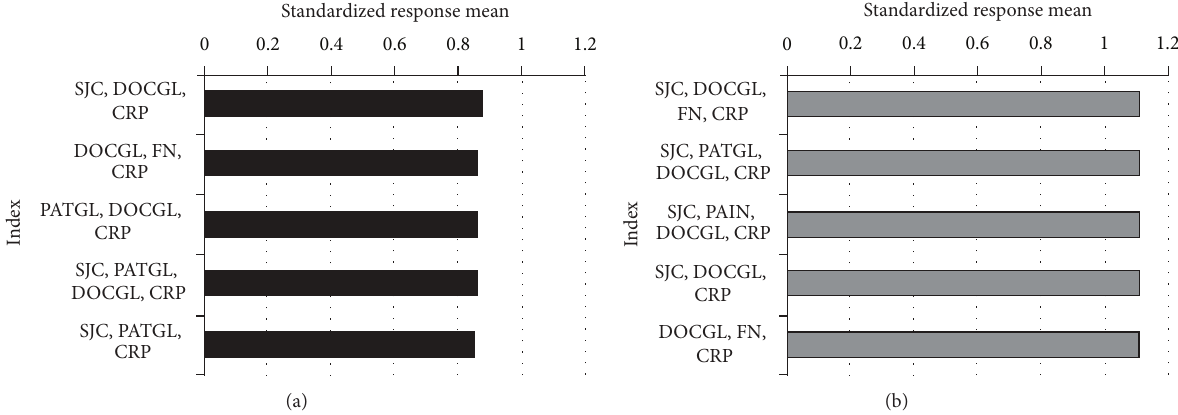
Figure 2: Indices with the greatest standardized response means in (a) DANCER (95% confidence interval for each index was ± 0.22. SRMs: DAS28 = 0.77, CDAI = 0.66, and RAPID3 = 0.60) and (b) REFLEX (95% confidence interval for each index was ± 0.18. SRMs: DAS28 = 1.04, CDAI = 0.92, and RAPID3 = 0.83). CRP: C-reactive protein; DOCGL: assessor global; FN: physical function; PATGL: patient global estimate; SJC: swollen joint count. Table 1: Patients’ baseline characteristics for key efficacy measurements and rheumatoid arthritis Core Data Set measures in the DANCER [6] and REFLEX [7] clinical trials. Mean (SD)